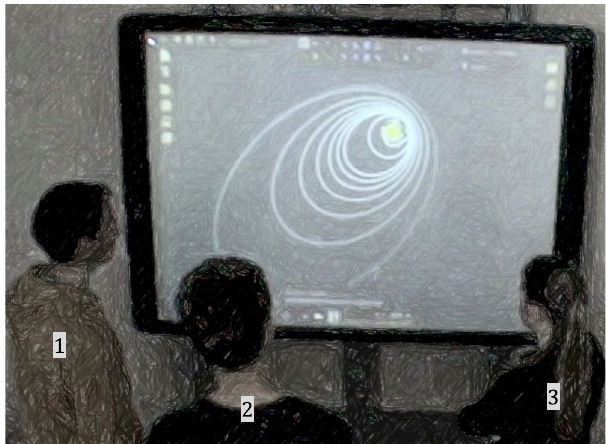
FIG. 9. The outcome of the experiment, where air resistance was introduced into the simulation of planets orbiting the Sun. The planets, as the students predicted, spiraled inwards towards the Sun. The spiral is